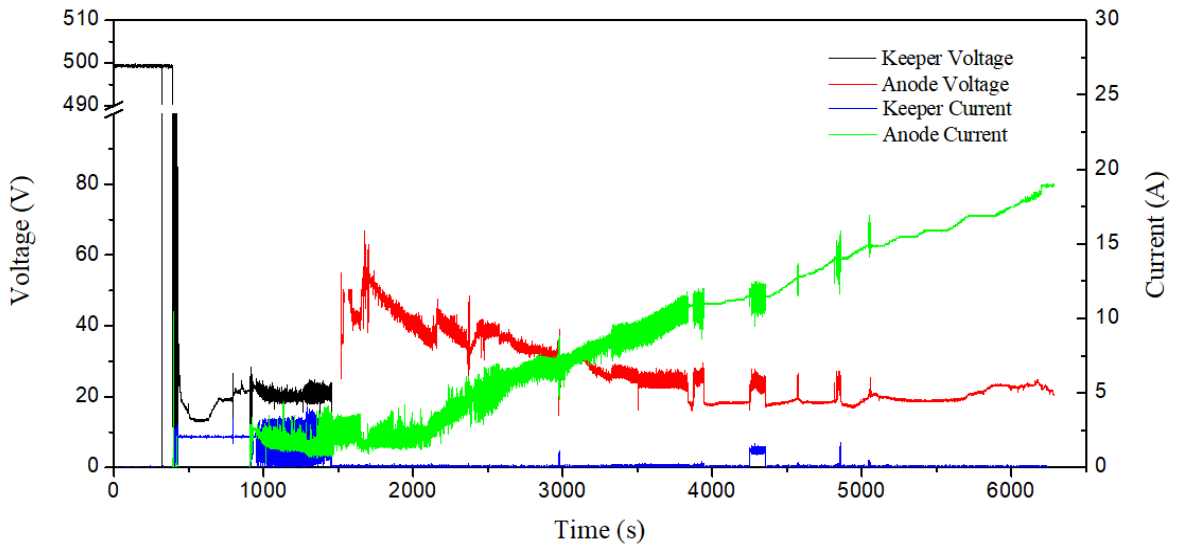
Figure 7. The volt–ampere characteristics curve of the C12A7 hollow cathode at a wide range of currents.